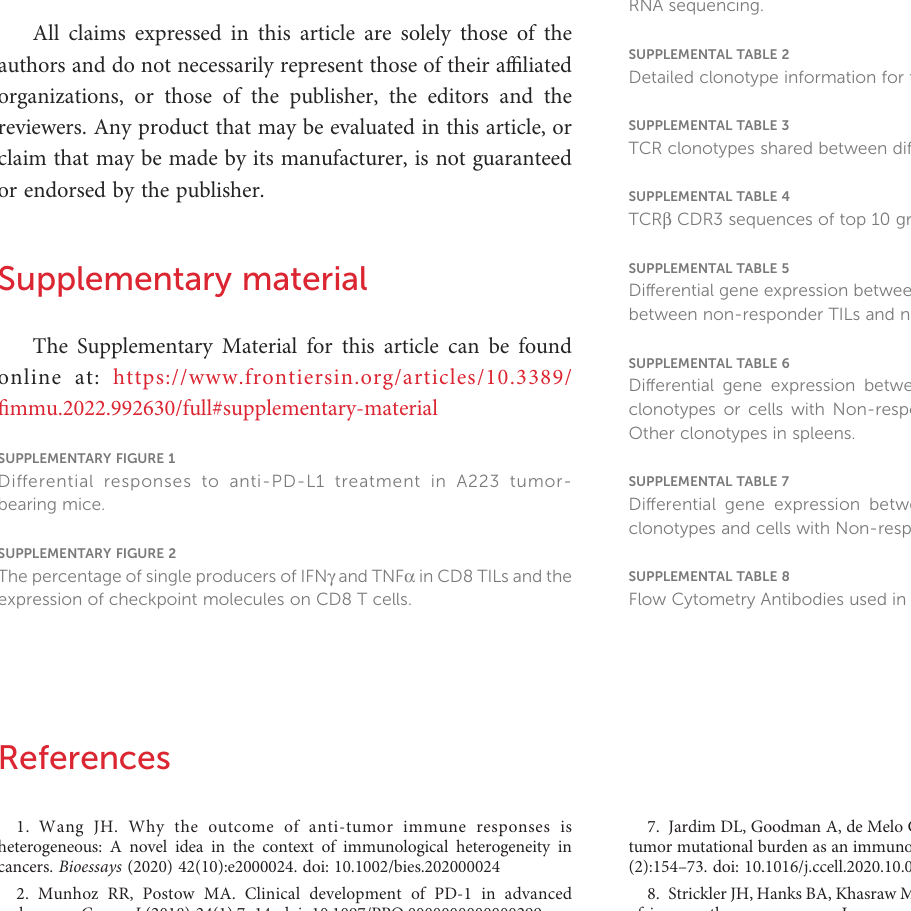
SUPPLEMENTAL TABLE 1 16 samples sequenced by Single-cell TCR and Single-cell RNA sequencing. SUPPLEMENTAL TABLE 2 Detailed clonotype information for top 10 TCR clones in each sample. SUPPLEMENTAL TABLE 3 TCR clonotypes shared between different TIL samples. SUPPLEMENTAL TABLE 4 TCR b CDR3 sequences of top 10 groups by GLIPH clustering. SUPPLEMENTAL TABLE 5 Differential gene expression between responder TILs and naïve T cells or between non-responder TILs and naïve T cells. SUPPLEMENTAL TABLE 6 Differential gene expression between either cells with Responder top